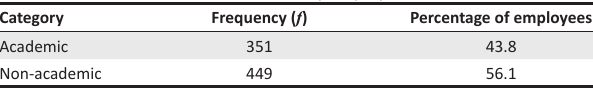
TABLE 1: The stratification of the university employees.